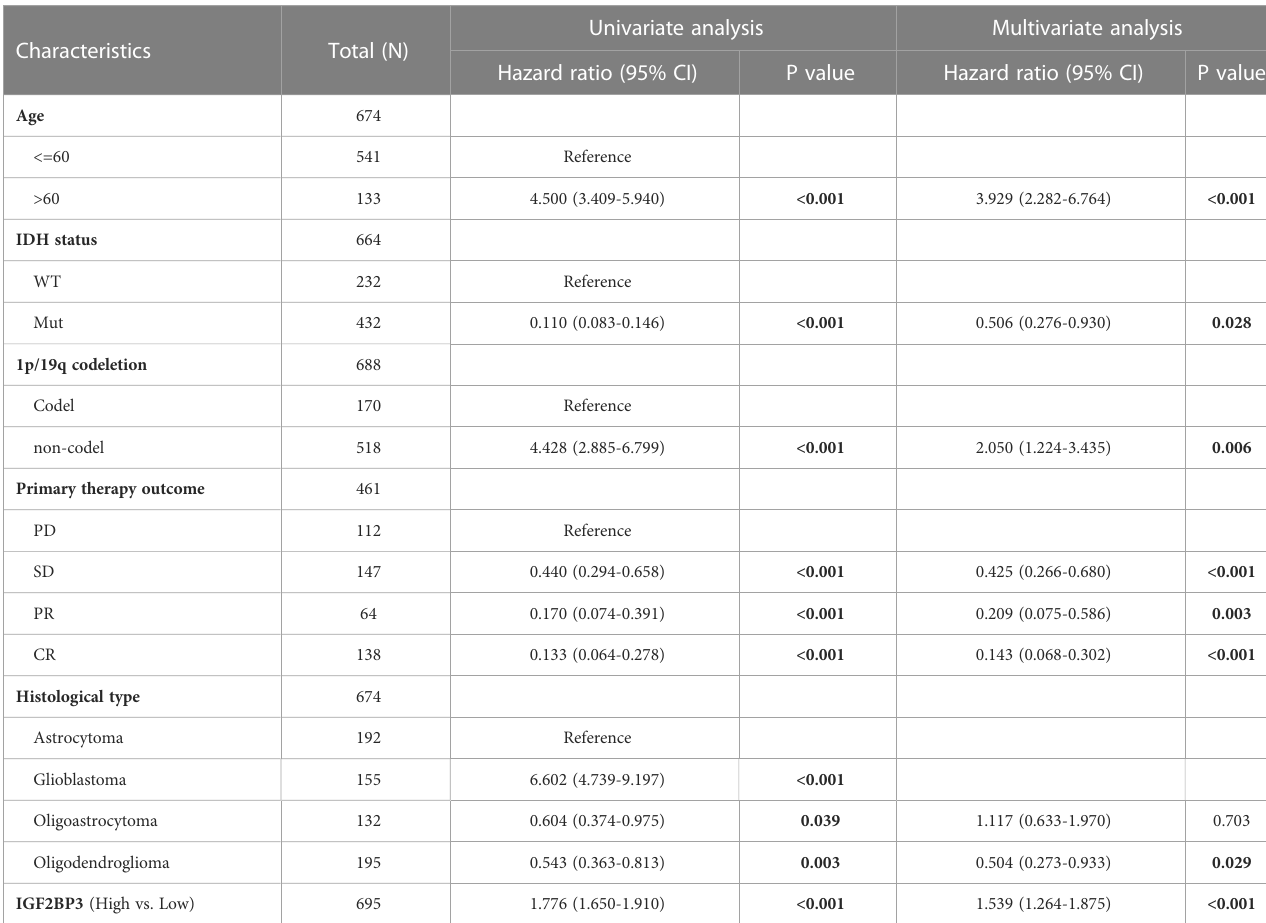
CESC (Figure 7A), LUAD (Figure 7B), LUSC (Figure 7C), LGG (Figure 7D), COAD (Figure 7E), STAD (Figure 7F), BLCA (Figure 7G), OV (Figure 7H), and BRCA (Figure 7I). In